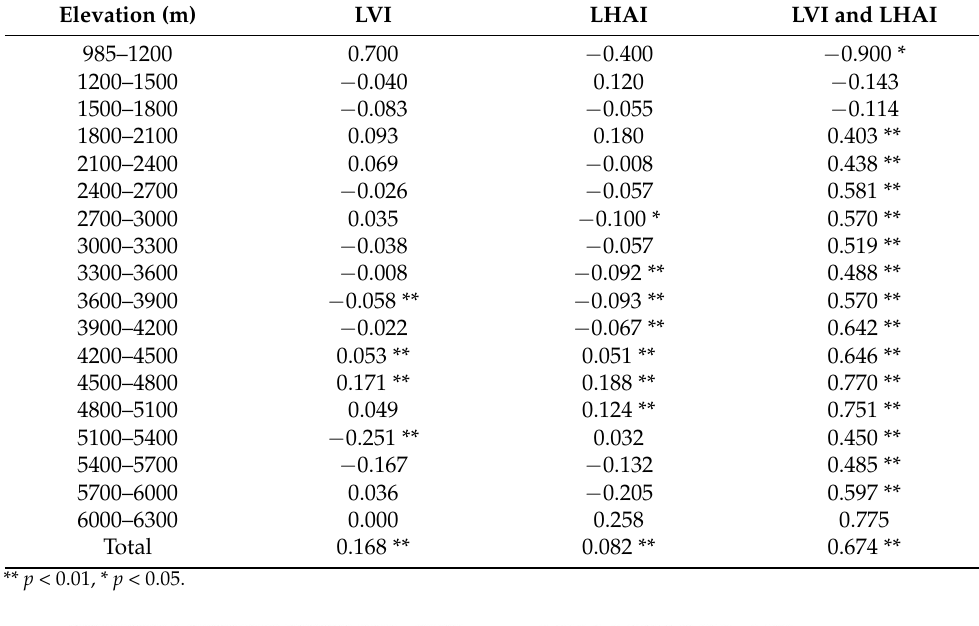
Table 7. Spearman correlation analysis between LVI, LHAI and elevation.